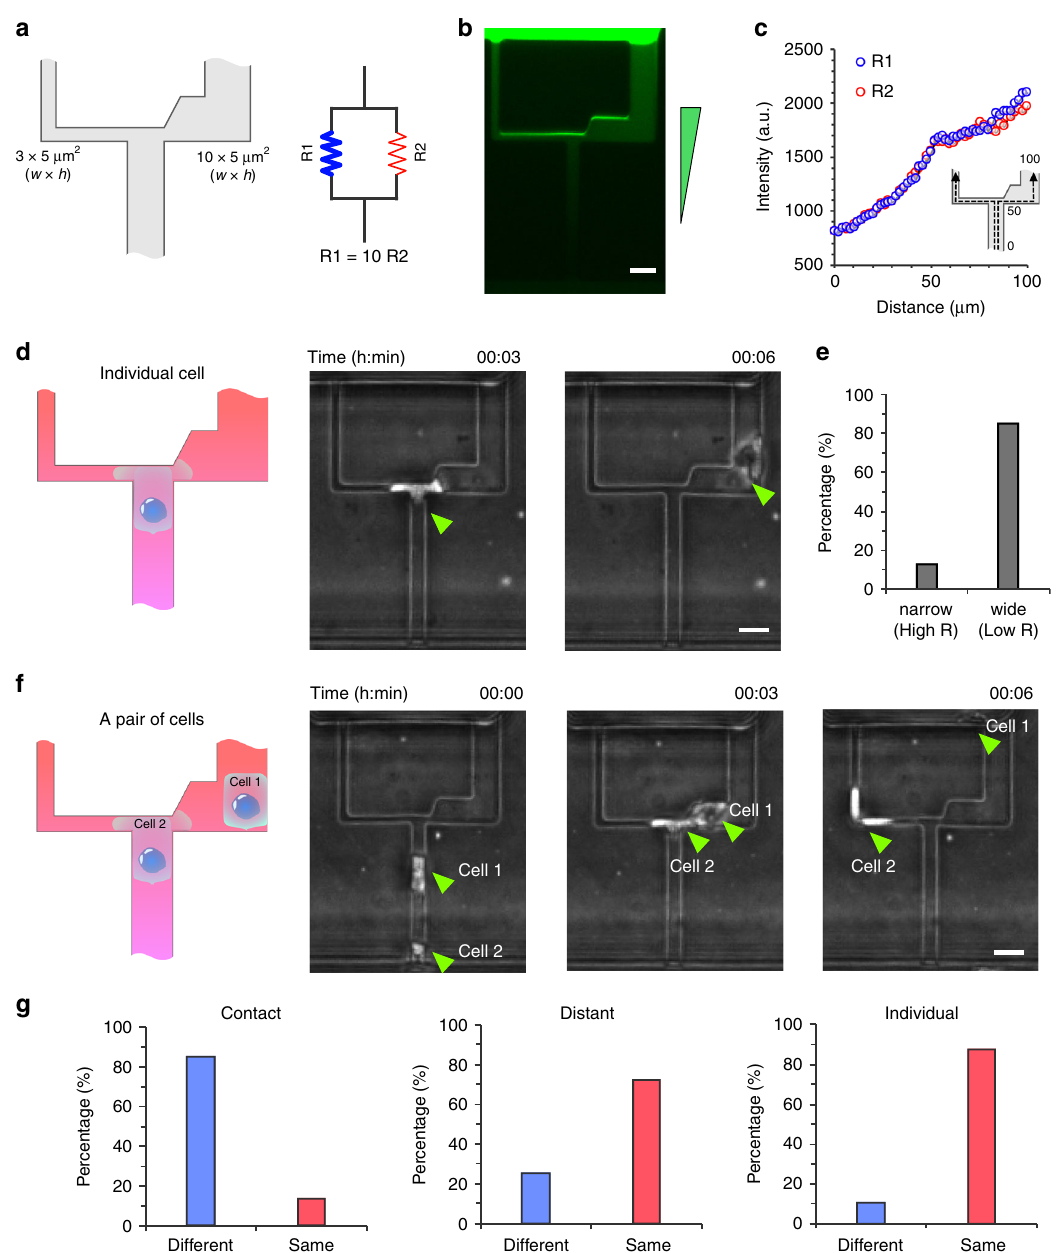
Fig. 7 Migration patterns of consecutive neutrophils at asymmetric bifurcations. a The design of the micro fl uidic asymmetrical bifurcation and the corresponding electric circuit model showing the hydraulic resistance of the channels. R1 and R2 represent the hydraulic resistance of the narrow and wide channels, respectively. b A fl uorescent microscopic image showing the fl uorescent gradient at the bifurcation. The scale bar is 10 µ m. c Measurements of the fl uorescent intensity pro fi les along narrow (blue) and wide (red) channels. d A schematic illustration and experimental time-lapse images showing an individual cell passing through the asymmetric bifurcation. The green arrows indicate the cell. The scale bar is 10 µ m. e A graph showing the percentage of cells entering the narrow and wide branches. ( N = 3 donors, N = 181). f A schematic illustration and experimental time-lapse images showing the entrance of consecutive neutrophils from two-neutrophil squads in asymmetric branches at a bifurcation. The green arrows indicate the cells. The scale bar is 10 µ m. g Graphs showing the percentage of neutrophil entering the same branch when migrating in two-neutrophil squads and in contact ( N = 3 donors, N = 49) or separate ( N = 3 donors, N = 31), or entering the channel individually ( N = 3 donors, N =